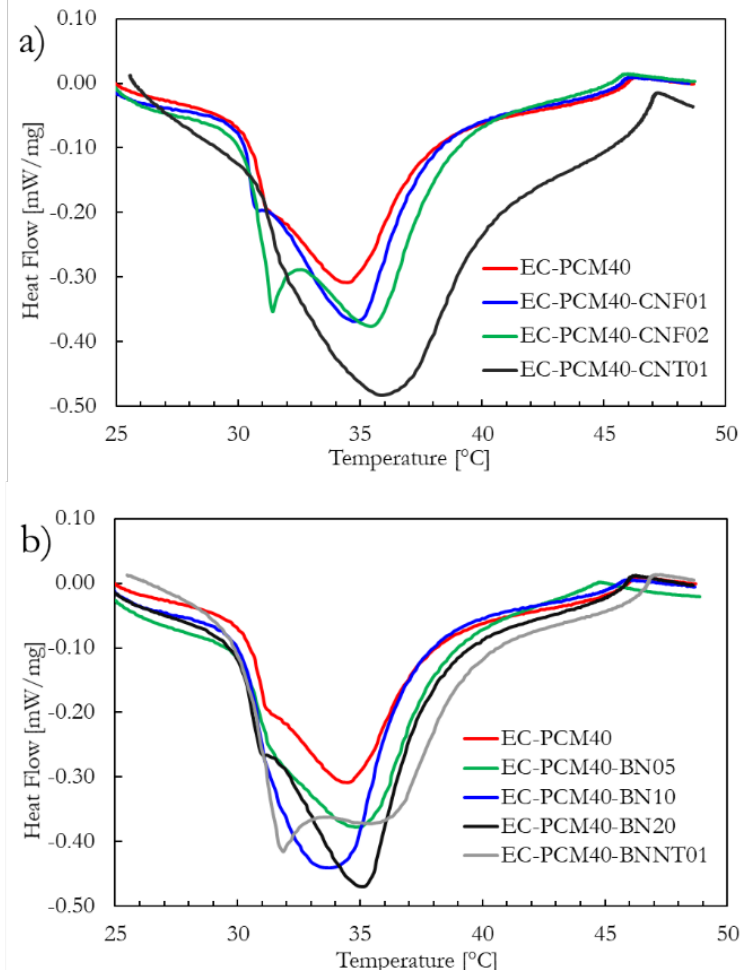
Figure 3 . Heating curves of the a ) epoxy–PCM formulations incorporated with carbon nanofillers and Figure 3. Heating curves of the ( a ) epoxy–PCM formulations incorporated with carbon nanofillers and b ) boron nitride and BNNT fillers. ( b ) boron nitride and BNNT